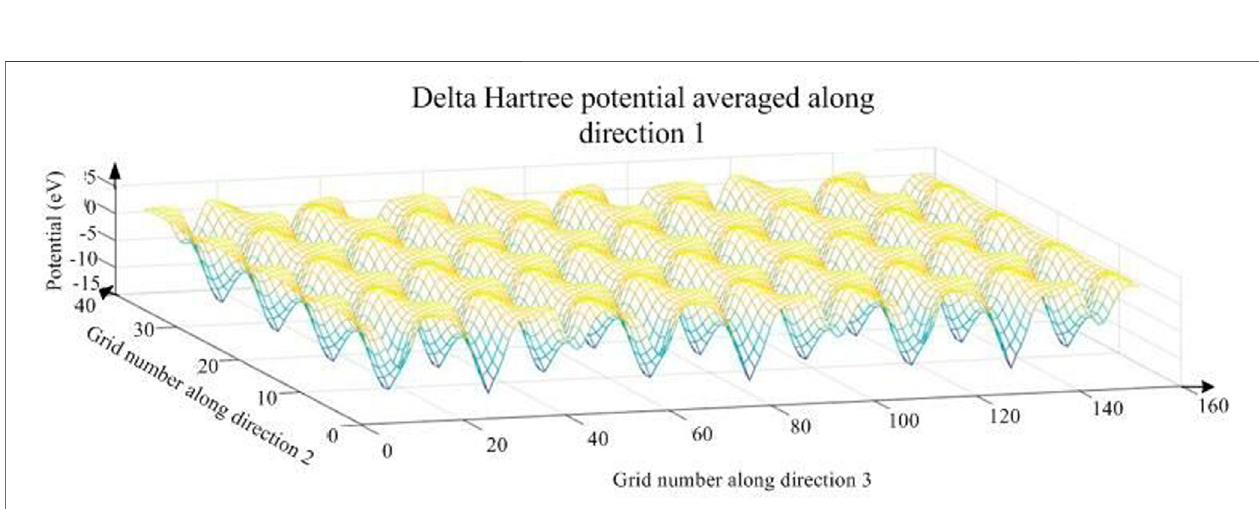
FIGURE 6 | 3D potential energy map of Li 1.1 Na 0.1 Mn 0.54 Ni 0.13 Co 0.13 O 2